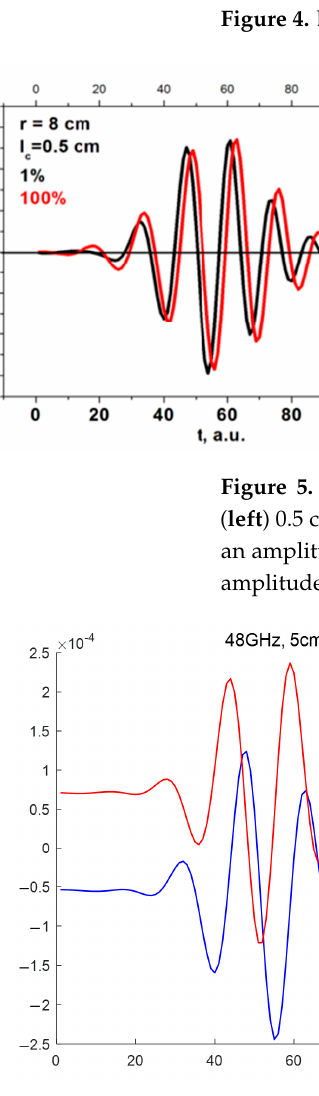
Figure 6. DBS IQ signals for the 48 GHz probing frequency for a circular filament with a 5 cm diameter: ( left ) amplitude of 1% of density at cutoff of the probing wave, ( right ) amplitude of 100% of density at cutoff of the probing wave.